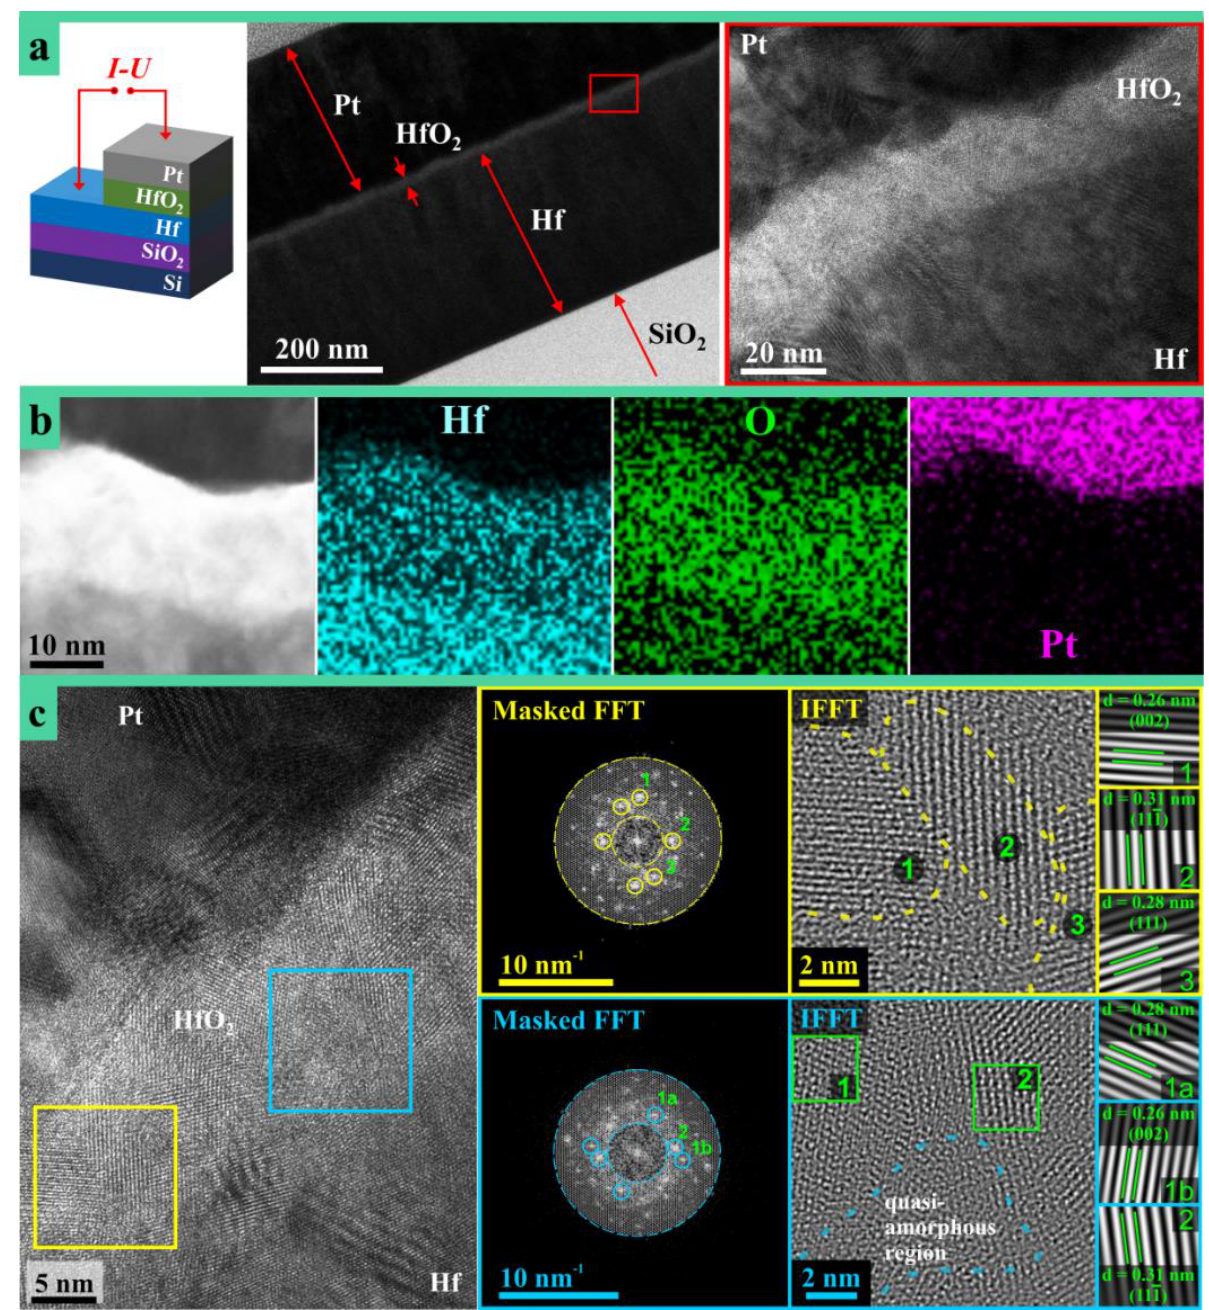
Figure 1. ( a ) Schematic description of the anodic memristor structure (grown in phosphate (PB)) with cross-section imaging for thickness observation and zoomed-in TEM view of the anodic oxide between Pt and Hf metallic electrodes. ( b ) Chemical analysis map (reconstructed using L series of characteristic X-Ray spectrum for Hf and Pt) of a small region FIB-cut through the anodic memristor (grown in PB) showing the species location in the device. ( c ) (HR)TEM imaging of an anodic memristor (grown in PB) along with masked FFTs of regions highlighted with blue and yellow frames. Section ( c ) also contains filtered IFFT and IFFT reconstructed from the masked reflexes in FFT images representing various crystallographic orientations. Assessed interplanar spacings with an accuracy of ± 2.5% are also presented in the inset. The area depicted with blue also contains ‘broad’ quasiamorphous regions.